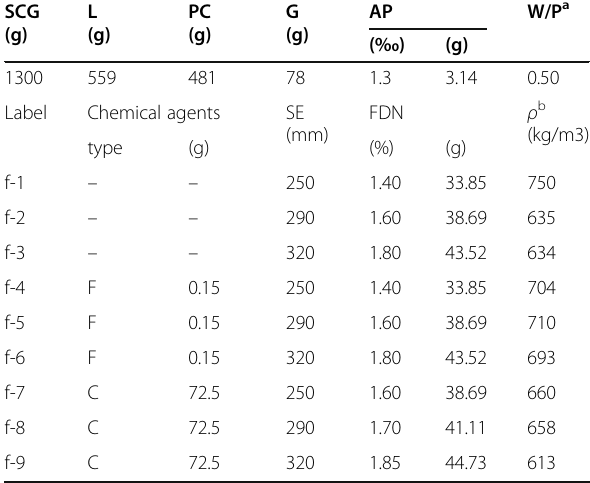
Table 2 Mix proportions of SCGAAC